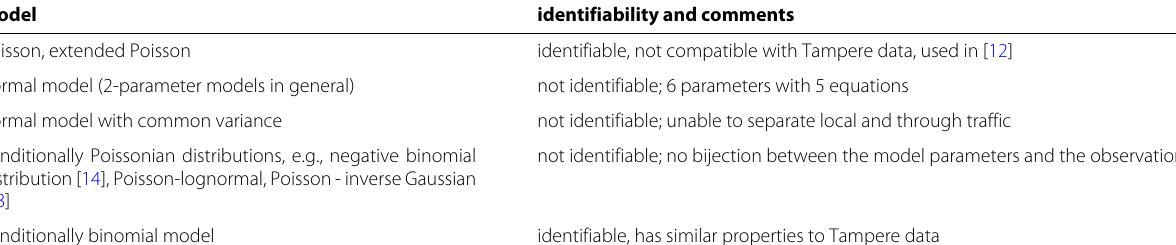
Table 1 Summary of possible traffic models and their identifiablity